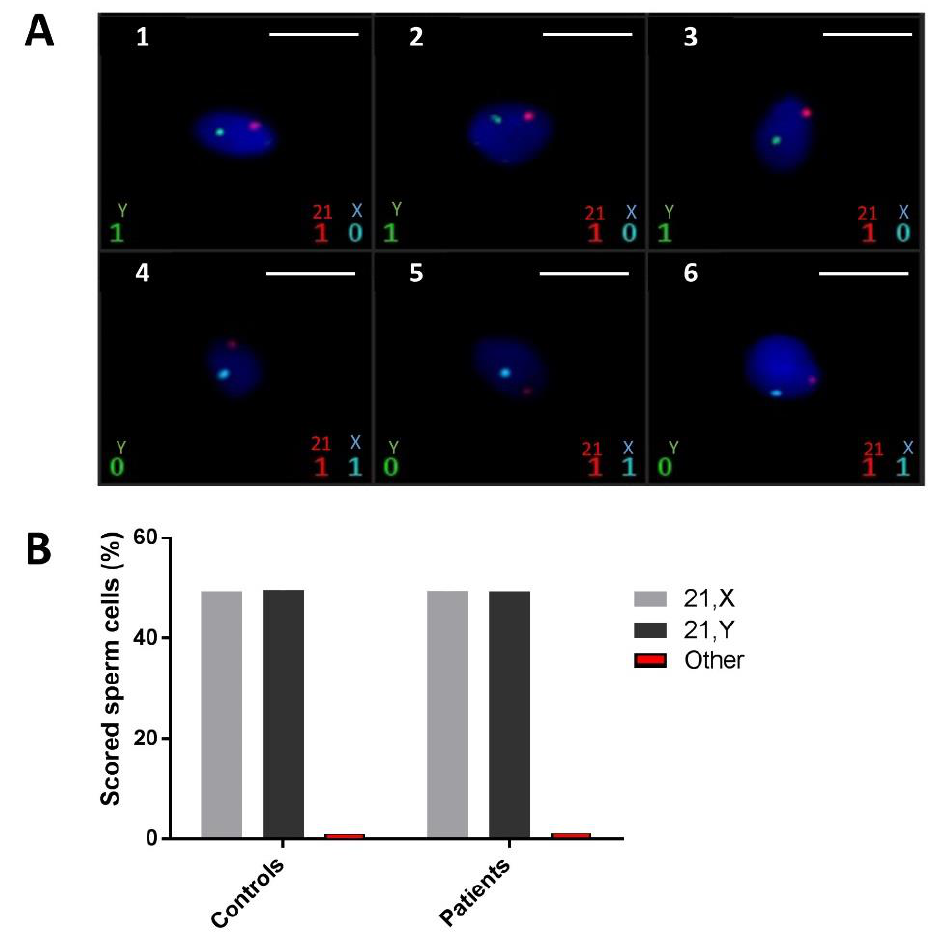
Figure 4. Sperm fluorescent in situ hybridization (FISH). ( A ) Images 1–6 show normal X, Y (blue and green spots, respectively) bearing sperm with no aneuploidy. Chromosome 21 is present every time (in red). Scale bars represent 5 µm. ( B ) Percentages of normal cells (21,X or 21,Y) and percentages of other types of ploidy (disomic for sex chromosomes, chromosome 21, or diploid cells).